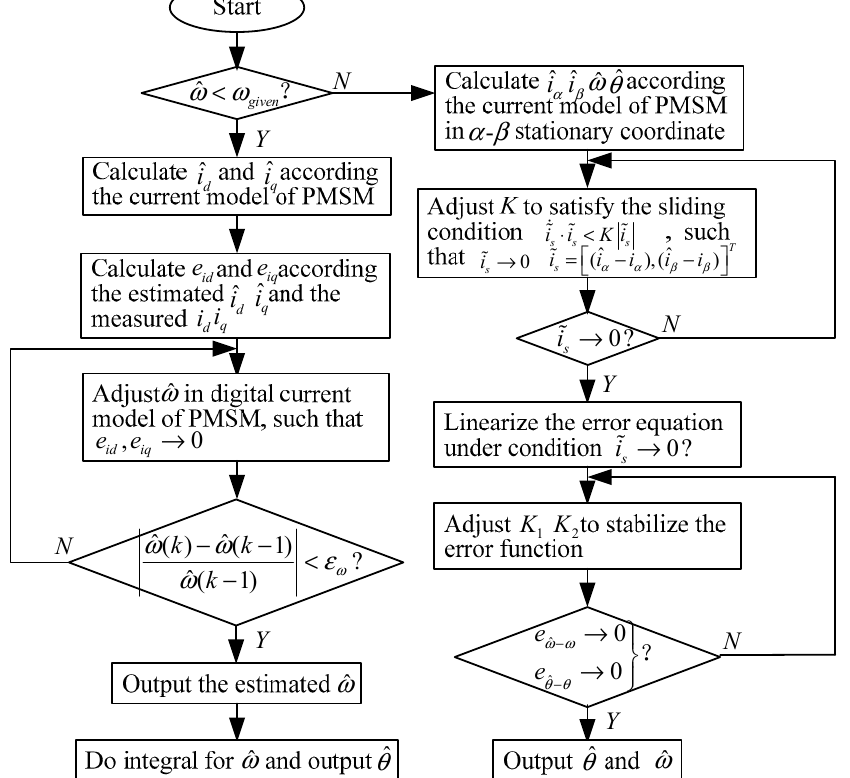
Figure 4. The flowchart for the implementation of hybrid observer.